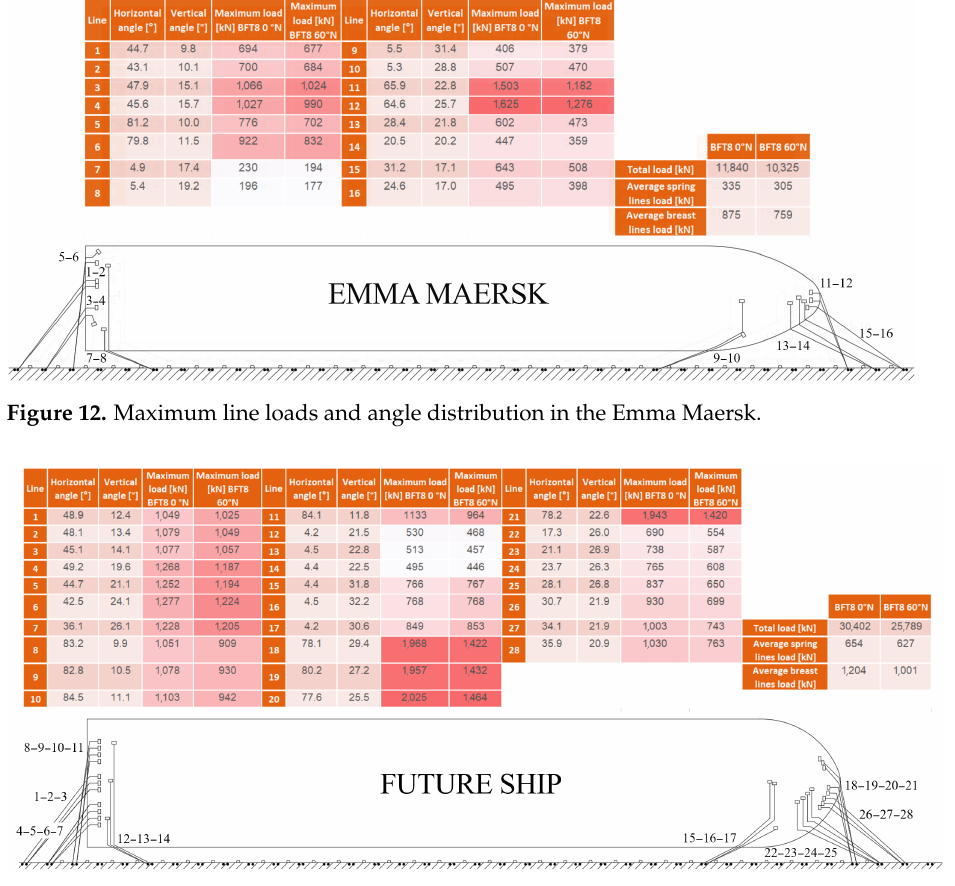
Figure 13. Maximum line loads and angle distribution in the future